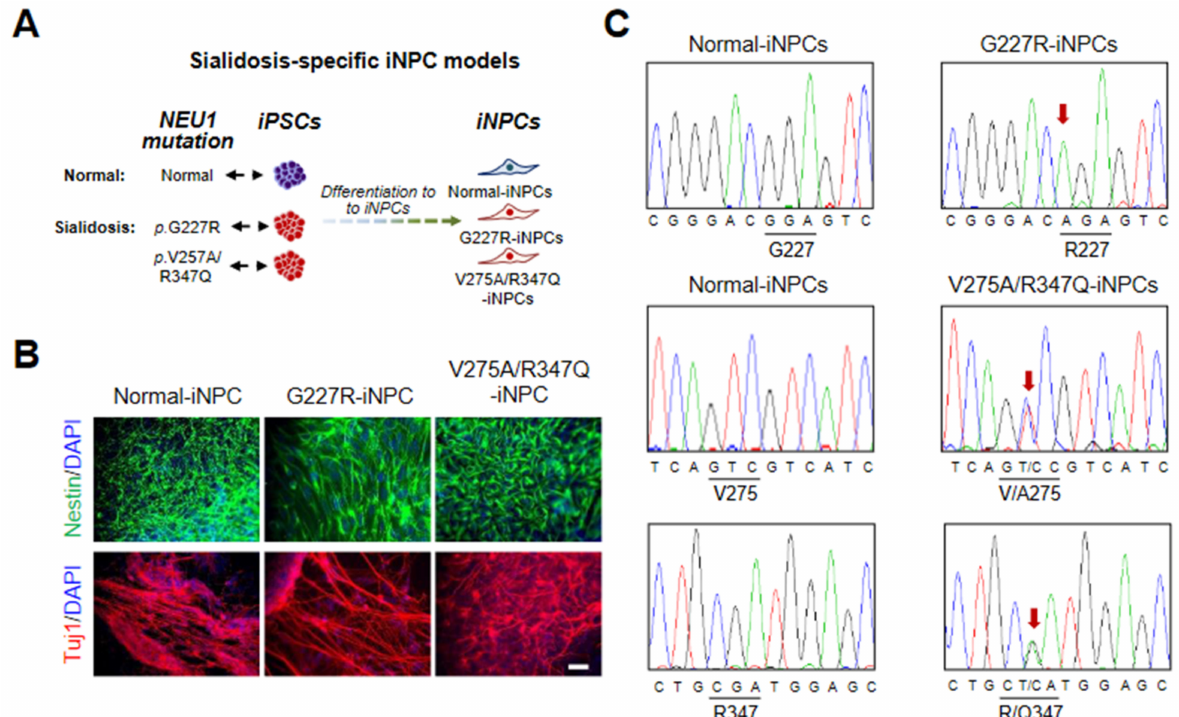
Figure 2. Derivation and characterization of normal and sialidosis-iNPCs. ( A ) Schematic representation of iNPC derivation from iPSCs. ( B ) Representative immunohistochemistry images of normal- and sialidosis-iNPCs (G227R- and V275A/R347Q- iNPCs) stained for the NPC markers Nestin and Tuj1. Nuclei were counterstained with DAPI (blue). (Scale bar = 50 µ m) ( C ) DNA sequences of the NEU1 gene in normal- and sialidosis-iNPCs derived from normal or sialidosis-iPSCs carrying the G227R or V275A/R347Q mutation in NEU1 .